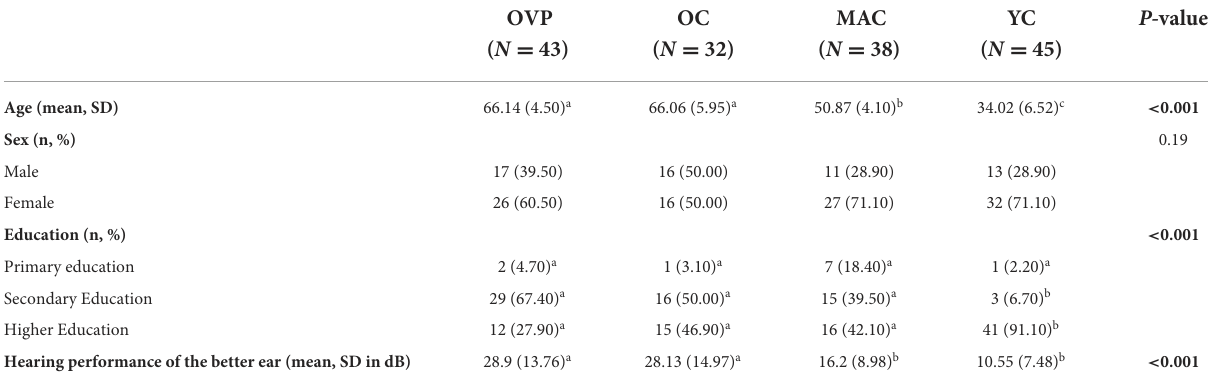
TABLE 1 Demographic, and hearing performance of all